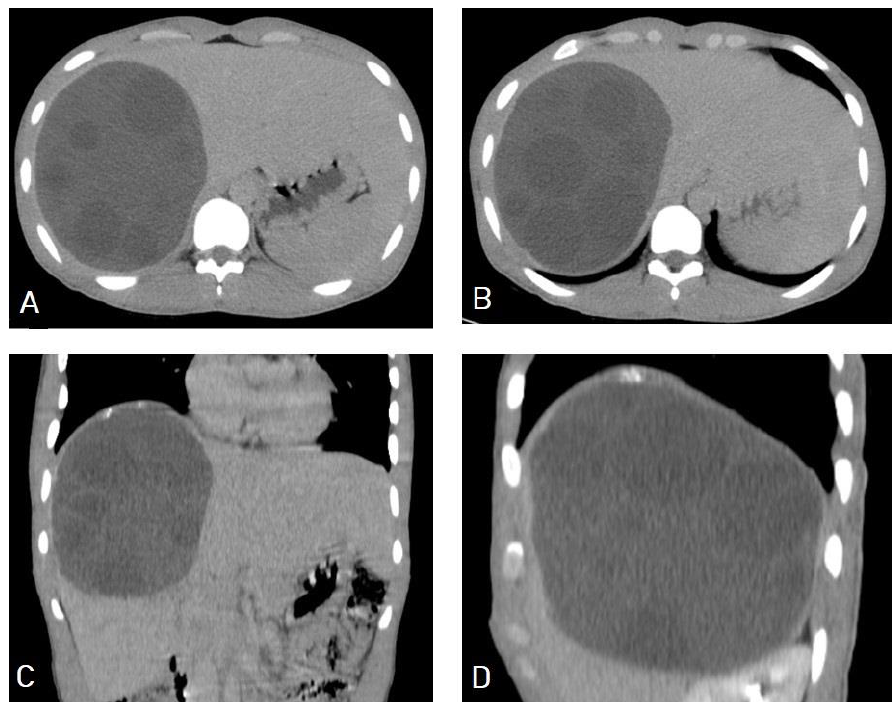
Figure 8. Selected axial ( A ) and coronal ( B ) CT images of a 60-year-old female showing multiple well-defined cystic lesions occupying the liver: about five lesions in the right lobe, where the largest one measured 17 × 9.2 × 15.3 cm (long arrows), occupying the right posterior lobe, and two cysts occupying the left lobe, where the largest one measured 11.4 × 10.3 × 8.7 cm (short arrows). Most of the lesions contain multiple vesicular cysts inside them (daughter cysts). The lesions exert a com- pression effect on the portal vein, stomach, and ascending colon, intending to reach the right kidney upper pole. This is a typical picture of an active-stage hydatid cyst Type IIA.